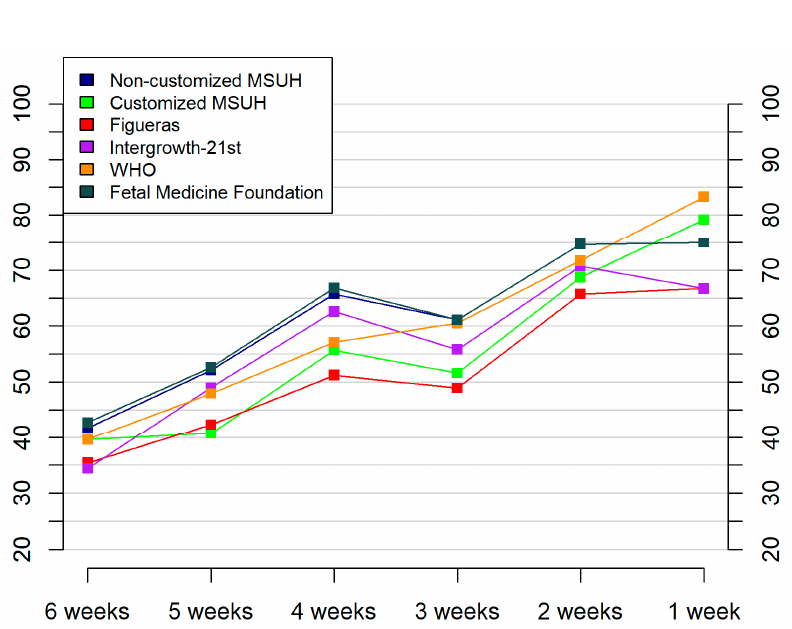
Figure 5. Prediction of small for gestational age cases, by standard and by ultrasound–delivery interval (1–6 weeks), for a 10% false positive rate. Growth standards: non-customized Miguel Servet University Hospital (MSUH), customized MSUH, Figueras et al., INTERGROWTH-21st, World Health Organization (WHO), and Fetal Medicine